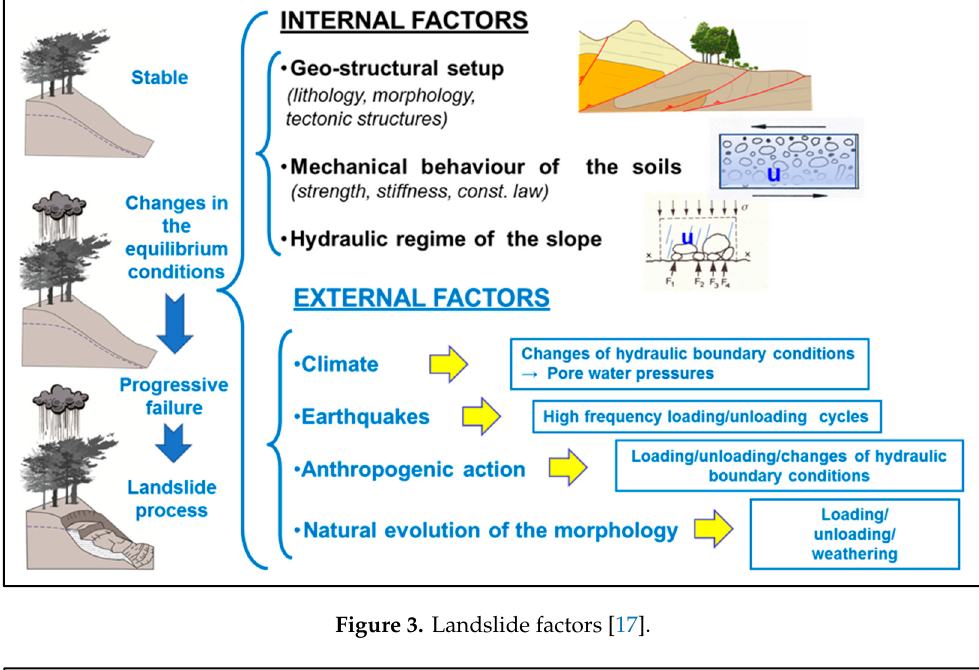
Figure 3. Landslide factors [17].